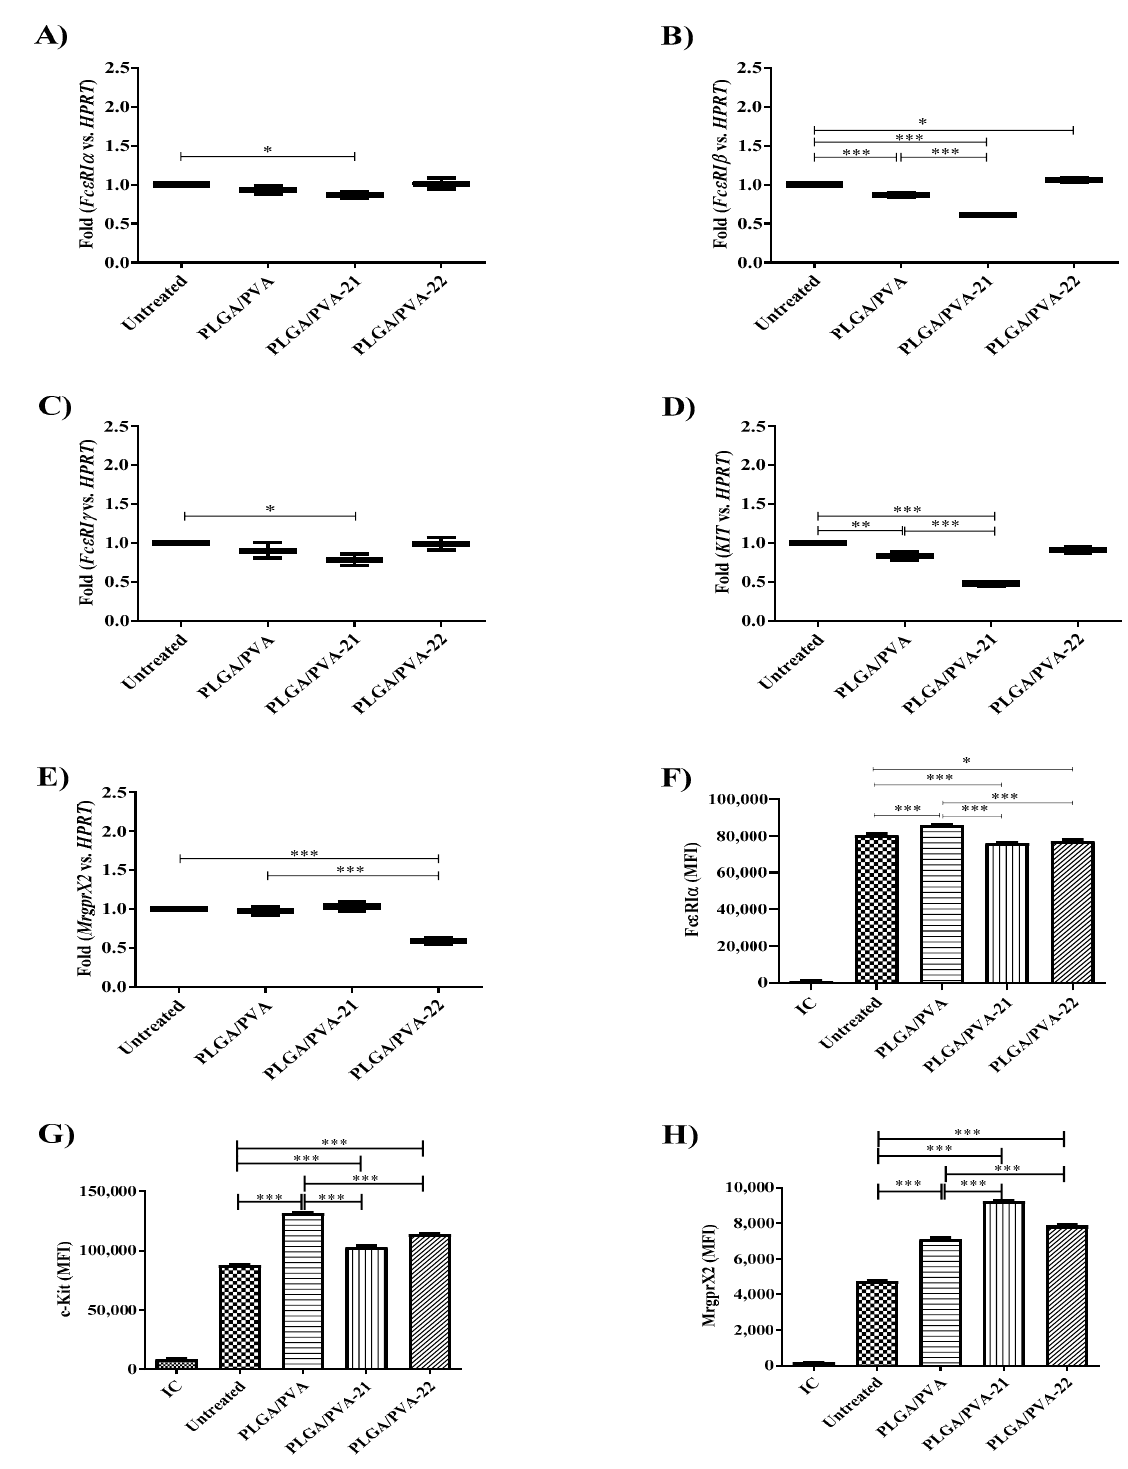
Figure 4. Effect of SQ nanoparticle administration to LAD2 cells on receptor expression. LAD2 cells were exposed for 6 h to PLGA/PVA-21, or PLGA/PVA-22, followed by RNA isolation, and cDNA synthesis. Gene expression levels of Fc ε RI α ( A ), Fc ε RI β ( B ), Fc ε RI γ ( C ), Kit ( D ), and MrgprX2 ( E ) were analyzed by real-time PCR, using HPRT1 to normalize gene expression ( n = 3 ± SEM; * p ≤ 0.05, ** p ≤ 0.01, *** p ≤ 0.001). Fc ε RI α ( F ), c-Kit ( G ), and MrgprX2 ( H ) protein synthesis by LAD2 cells treated for 24 h with PLGA/PVA-21, or PLGA/PVA-22 were analyzed by flow cytometry. Untreated and PLGA/PVA-treated cells were included as controls in all tested conditions. ( n = 3 ± SEM; * p ≤ 0.05, ** p ≤ 0.01, *** p ≤ 0.001) .